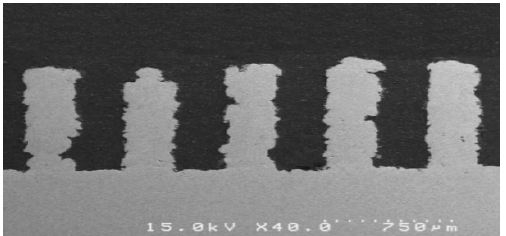
Figure 8. SEM image of the flow field of the PBF-built SUS 316L BP.